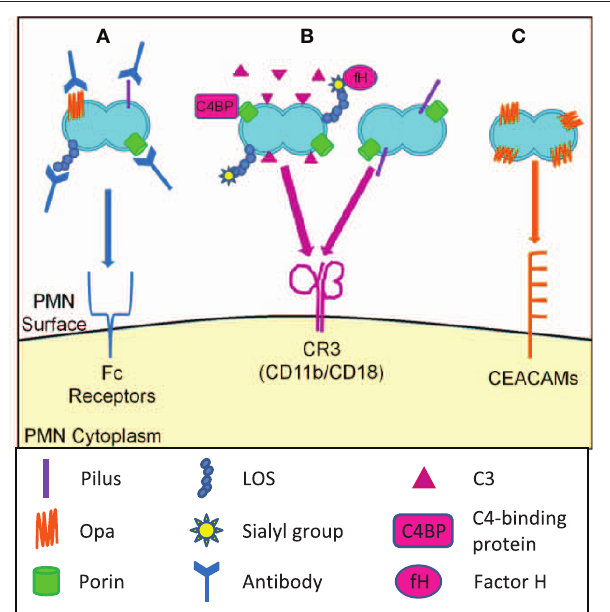
Figure 3 | Opsonic and non-opsonic phagocytosis of gc by PMNs. (A) Antibodies that recognize Gc surface structures opsonize the bacteria and allow for phagocytosis via Fc receptors. The efficacy of immunoglobulin- mediated phagocytosis is questionable given the extensive phase and antigenic variation of Gc surface structures. (B) Gc binds factor H and C4 binding protein, resulting in opsonization of Gc with C3 and other complement components. Gc is then phagocytosed via the CR3 receptor. Gc pili and porin can cooperatively interact with CR3, which may mediate the non-opsonic phagocytosis of Gc by PMNs. (C) Selected Opa proteins bind to CEACAM family receptors expressed on PMNs, leading to non-opsonic phagocytosis of Opa